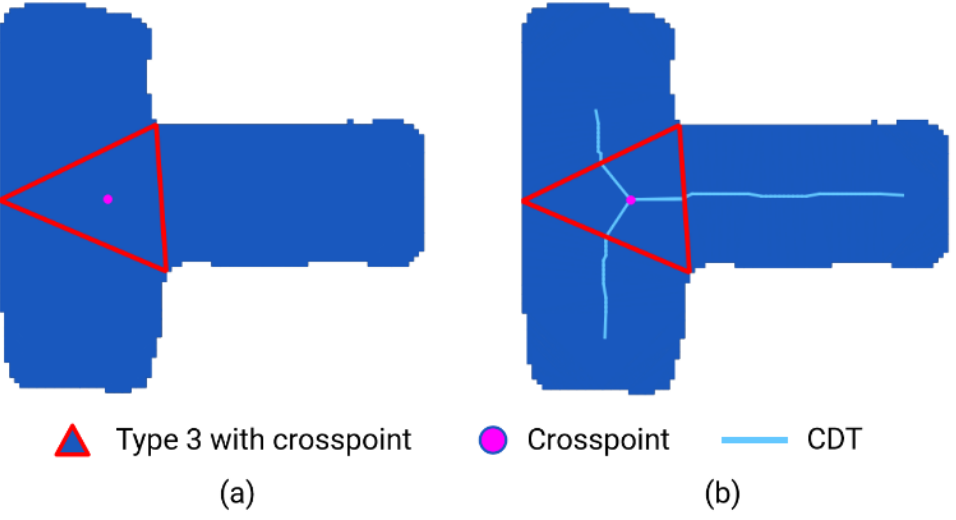
Figure 11. VRDI extraction results. ( a ) The MBR of building; ( b ) Result of VRDI method for crosspoint.